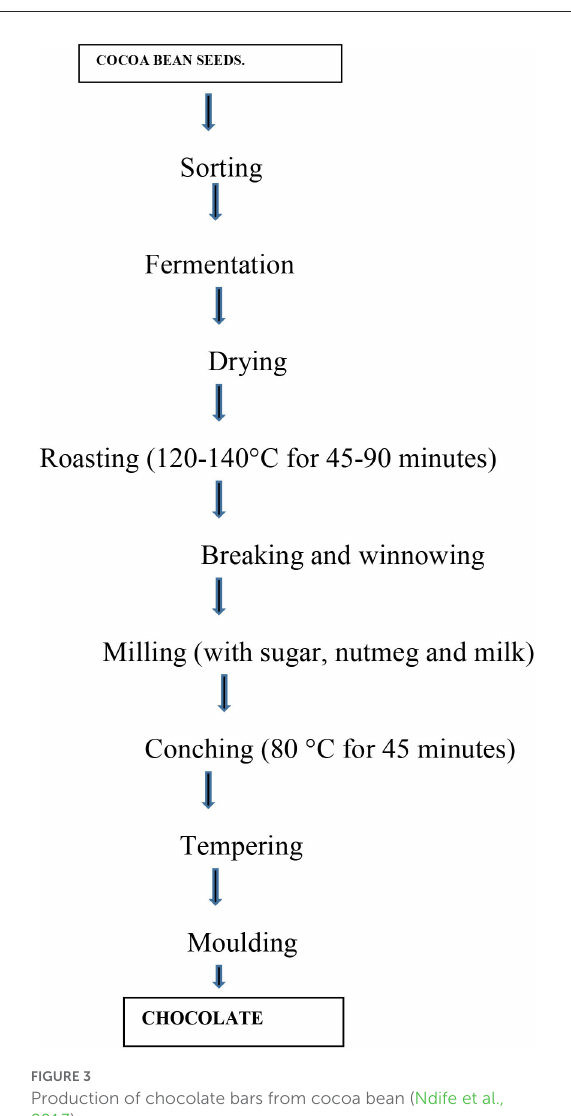
FIGURE3 Production of chocolate bars from cocoa bean (Ndife et al.,